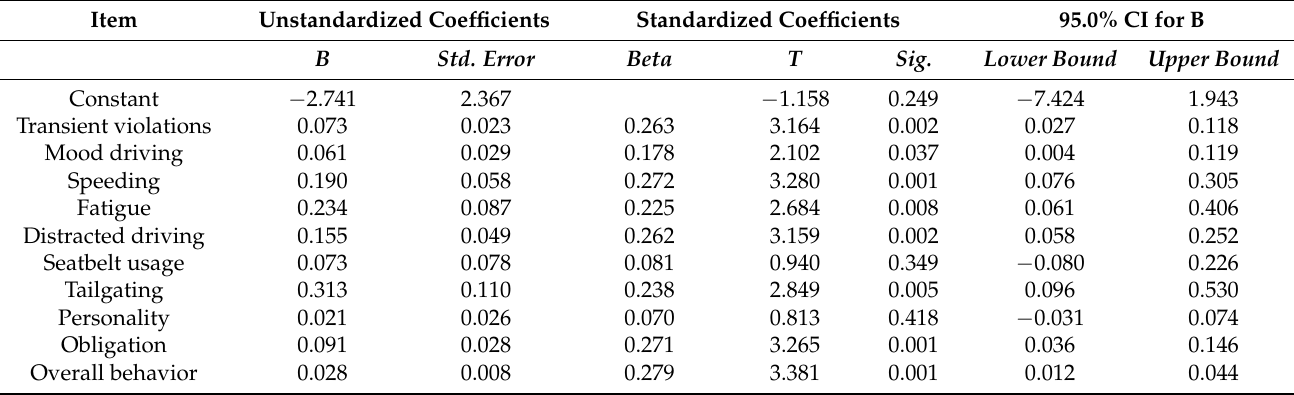
Table 7. Causal relationship between psychosocial-behavioral parameters and number of faults when involved in an accident.